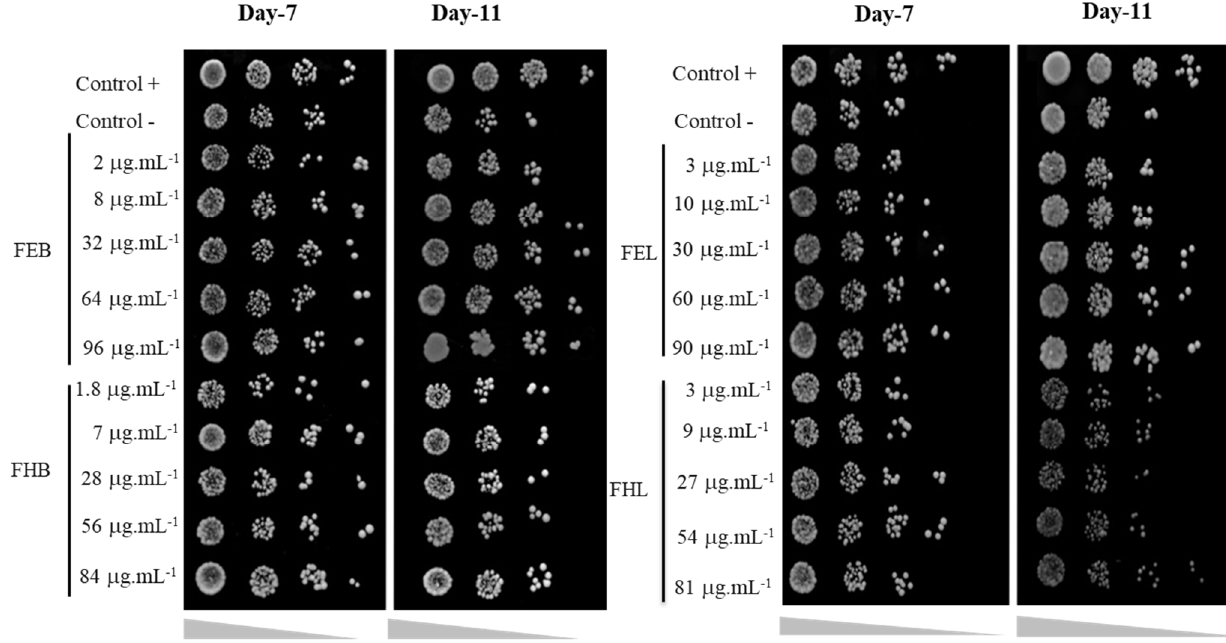
Figure 1. Effect of clove fraction treatment at various concentrations on the viability of S. pombe yeast grown on solid YES medium on the 7th and 11th days of incubation. FHB: clove bud n-hexane fraction, FHL: clove bud n-hexane fraction, FEB: clove bud ethanol fraction and FEL: clove leaf ethanol fraction. Yeasts grown on 0.3% and 3% glucose media without clove fraction were used as positive and negative controls, respectively.